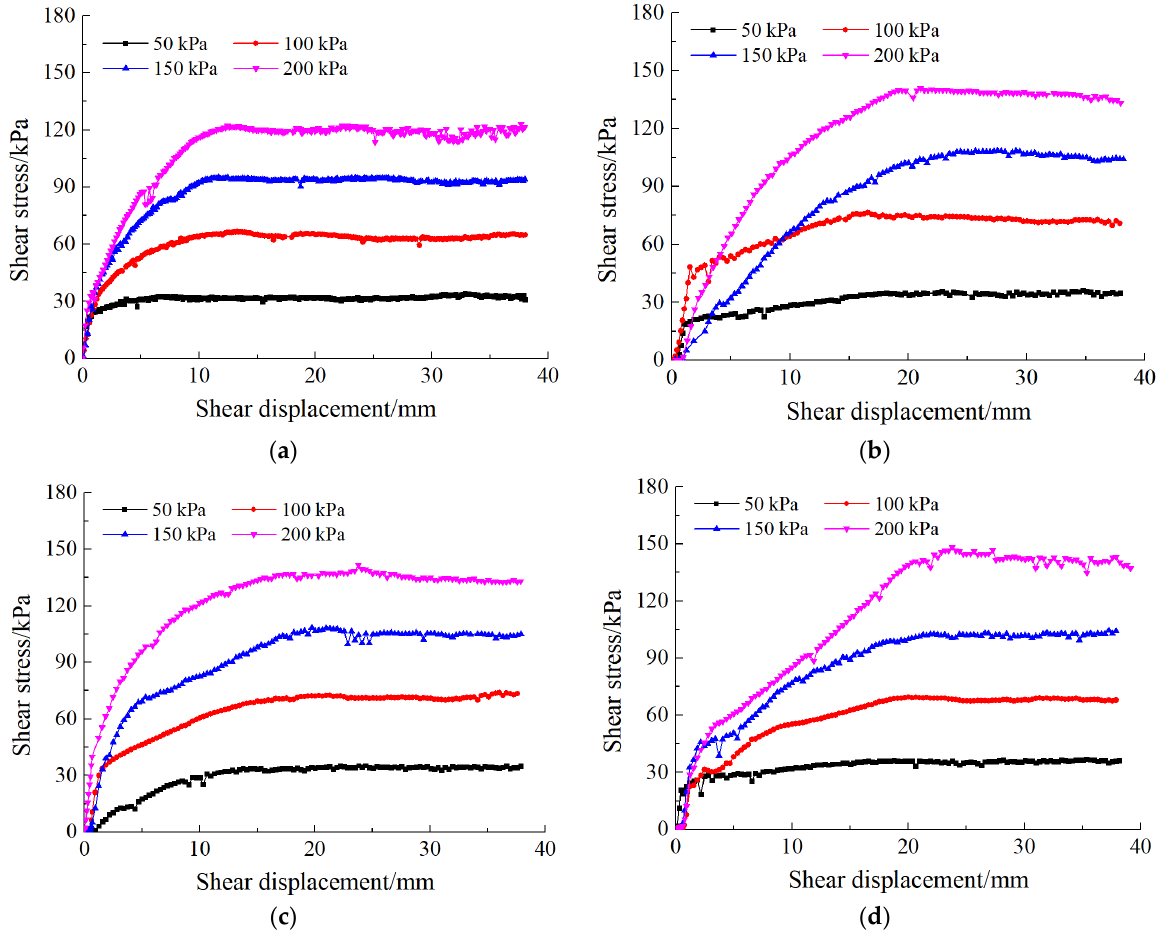
Figure 11. The relation curve of interface shear stress and shear displacement between sand and concrete specimens corroded different periods. ( a ) Concrete plate eroded for 0 days (uncorroded); ( b ) Concrete plate eroded for 31 days; ( c ) Concrete plate eroded for 93 days; ( d ) Concrete plate eroded for 154 days.